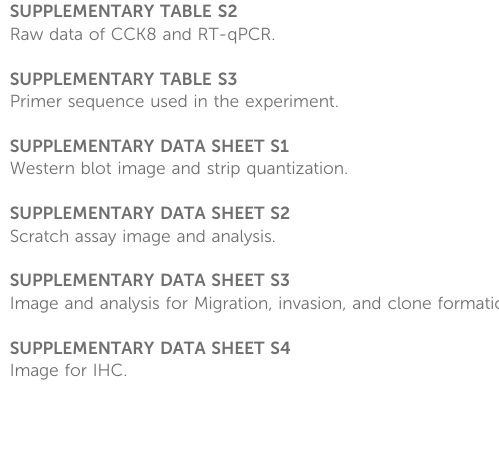
SUPPLEMENTARY TABLE S2 Raw data of CCK8 and RT-qPCR. SUPPLEMENTARY TABLE S3 Primer sequence used in the